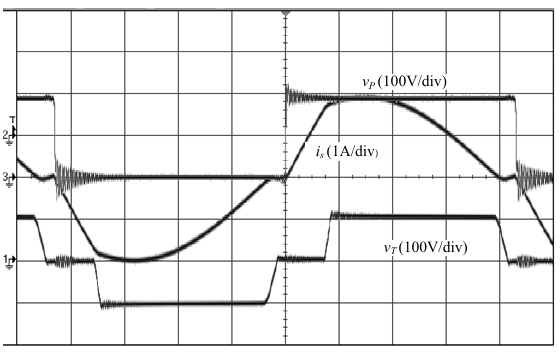
Figure 15. Experimental plot at: d > 1; V in = 90 V; V o = 100 V; P o = 90 W, CCM3 operation.